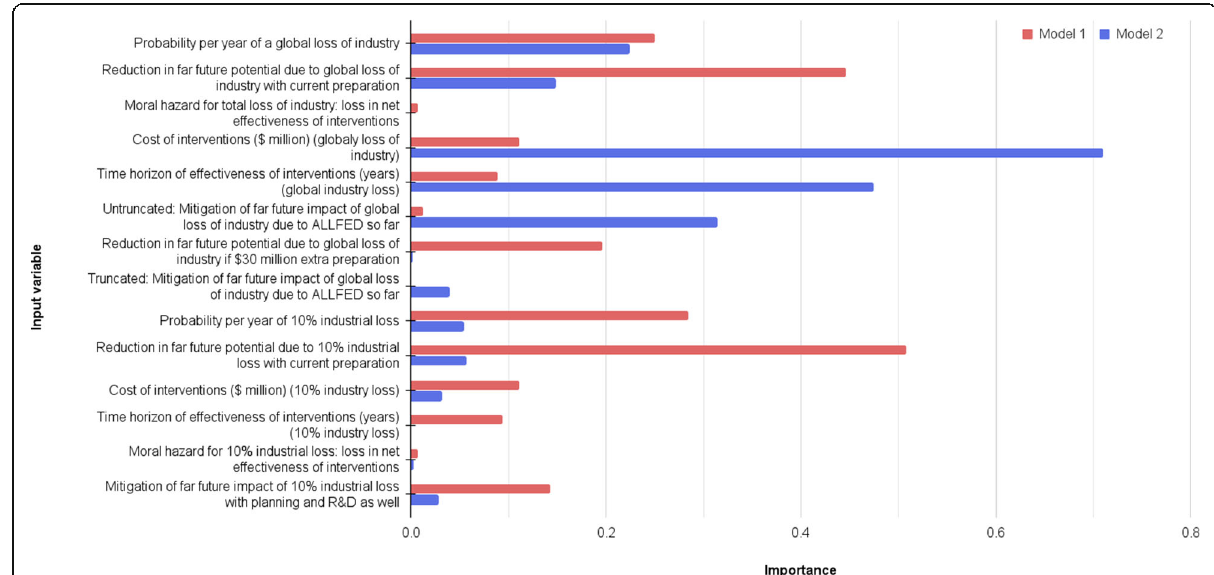
Fig. 7 Importance analysis results for Far future potential increase per $ due to loss of industry preparation for model 1 and model